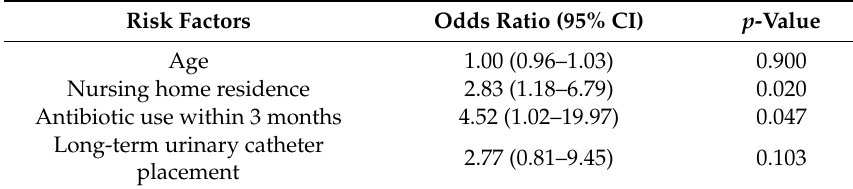
Table 4. Multivariate analysis for resistant Gram-negative